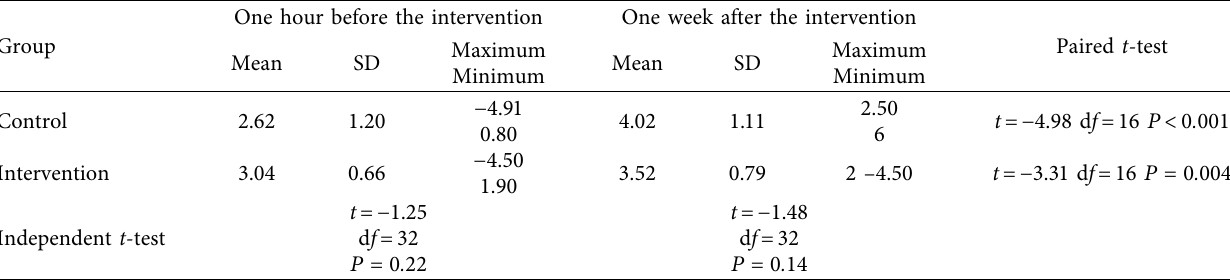
Table 2: Comparison of phosphate levels in the intervention and control groups one hour before and one week after the intervention, 2018. Group